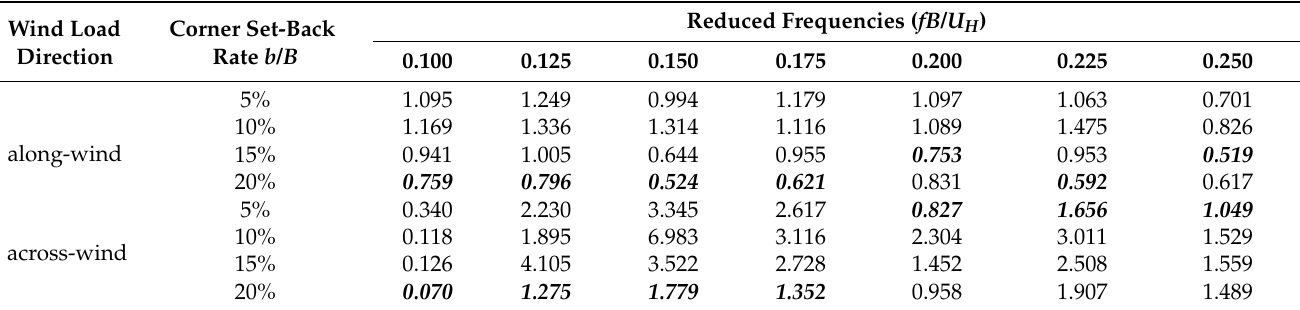
Figure 14. The correlation factors for base moment power spectra. ( a ) Along−wind. ( b ) Across−wind. Table 1. The correlation factors for power spectral densities of base moment coefficients in typical frequencies.